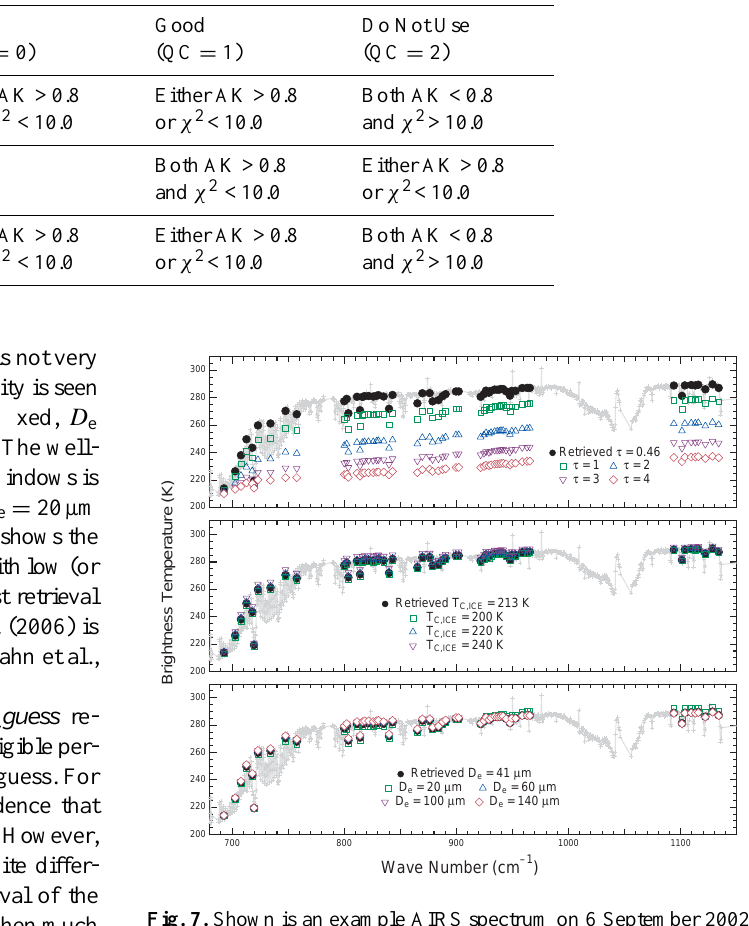
Fig. 7. Shown is an example AIRS spectrum on 6 September 2002 located in granule #44 (same as Fig. 1). The retrieval is for a rel- atively thin cirrus cloud and is located at 15.6 ◦ N and 132.6 ◦ W. The upper panel shows the best fit for τ = 0 . 46, and adjustments to 1.0, 2.0, 3.0, and 4.0. The middle panel shows the best fit for D e = 41µm, and adjustments to 20.0, 60.0, 100.0, and 140.0µm. The lower panel shows the best fit for T C , ICE = 213K, and adjust- ments to 200, 220, and